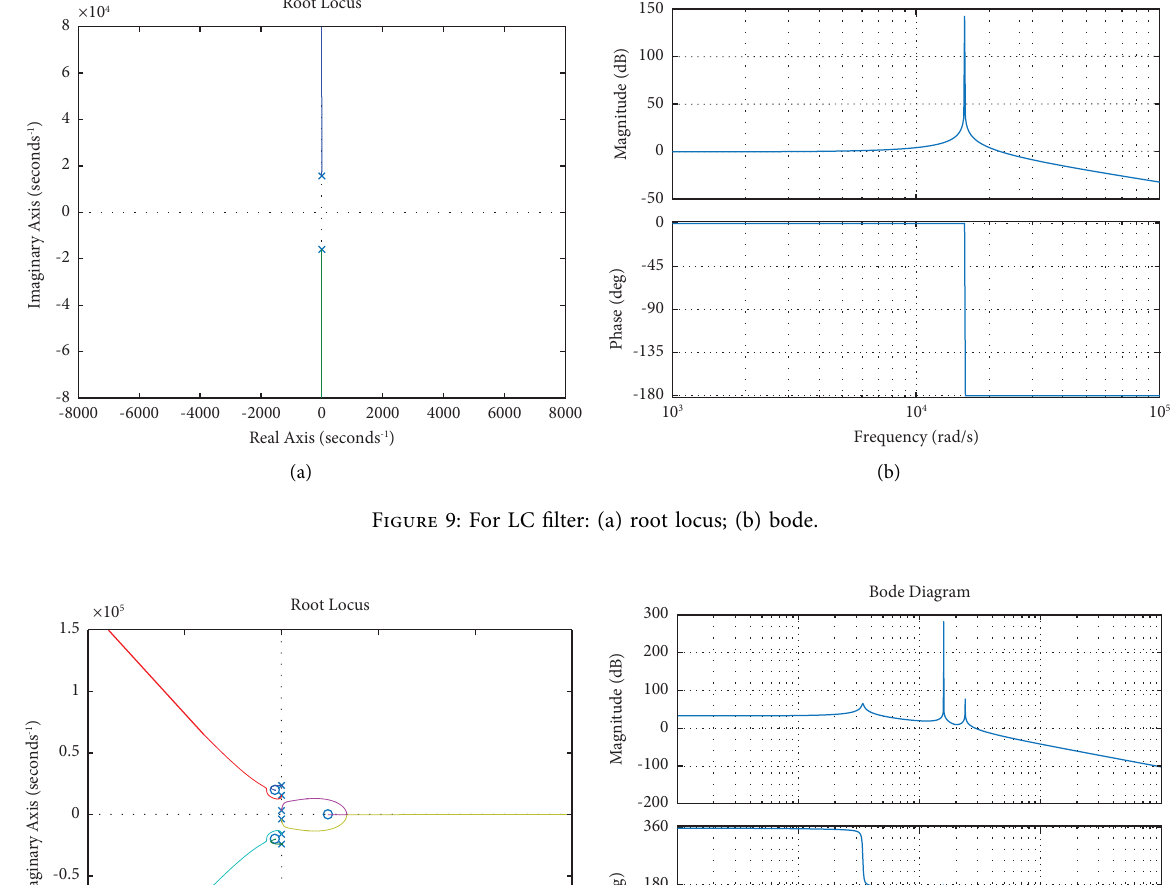
Figure 10: Cuk converter with LC flter: (a) root locus; (b) bode.